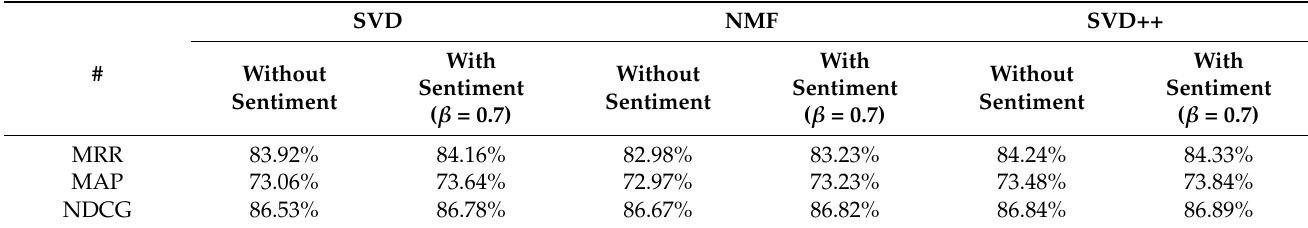
Table 7. MRR, MAP, and NDCG values without and with C-LSTM sentiment model on Amazon Fine Foods Reviews with β =